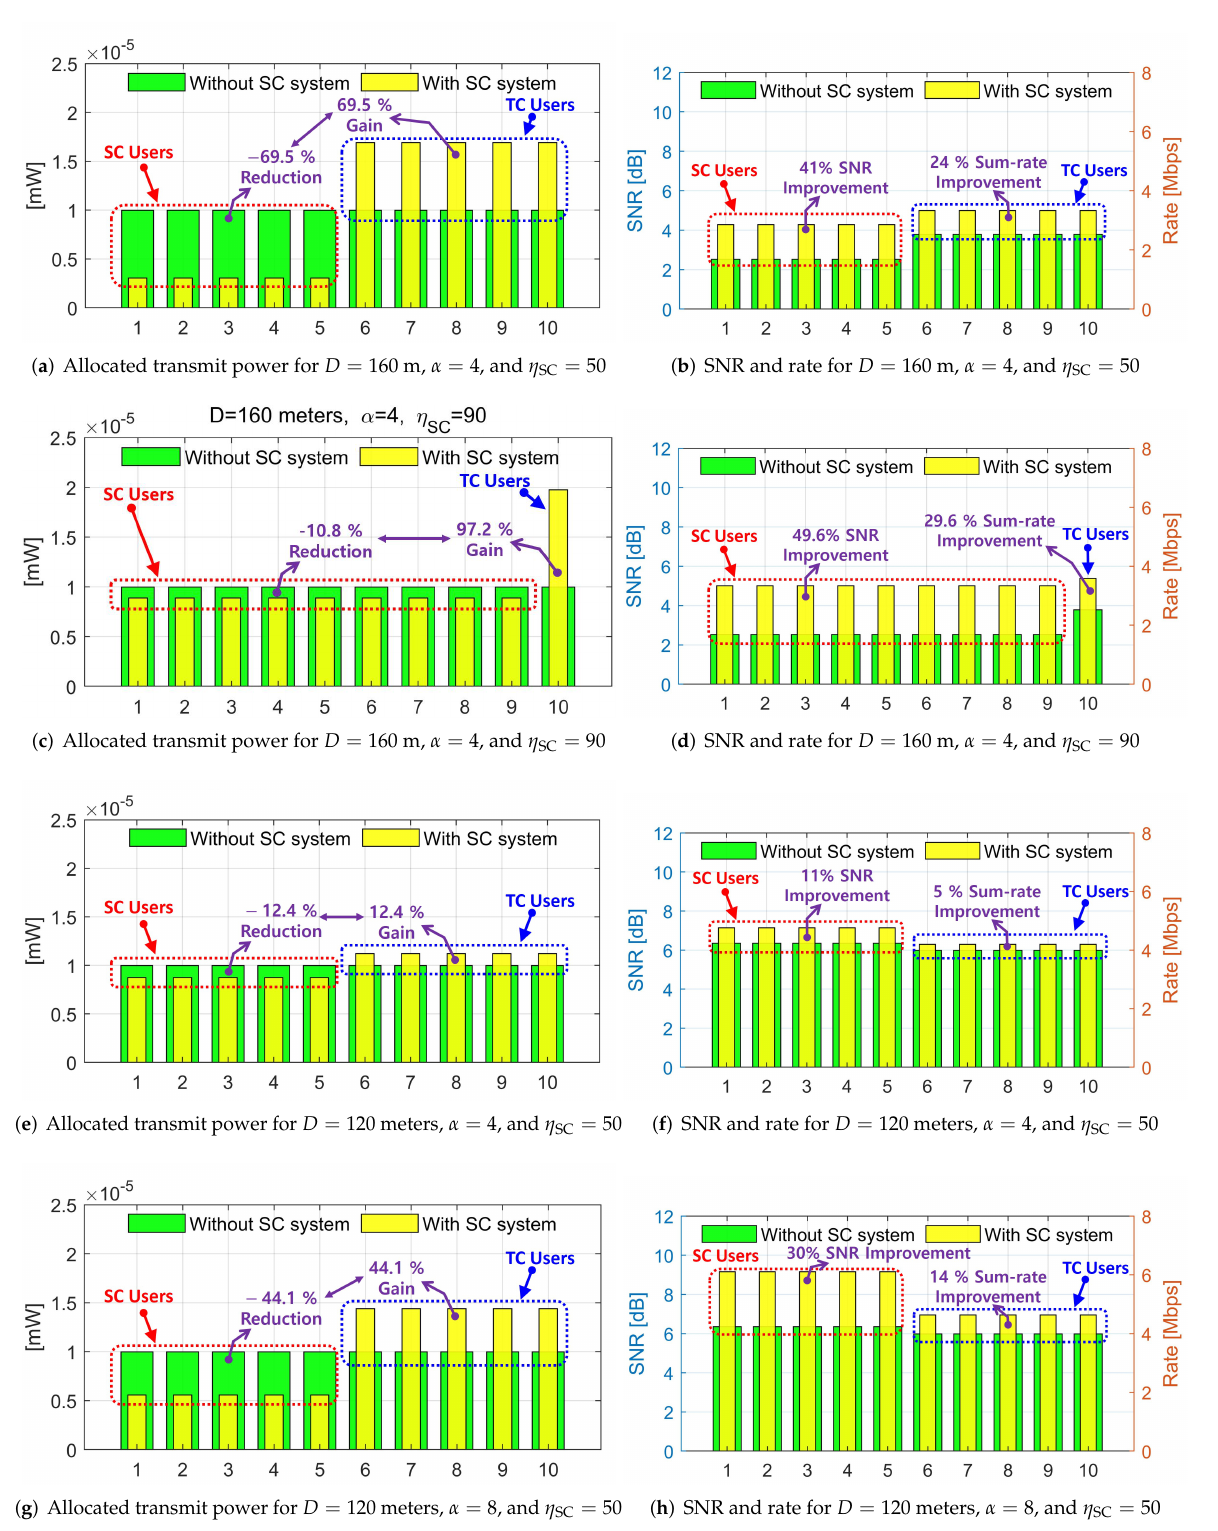
Figure 4. Comparison of the transmit power of all users, the SNR of SC users, and the rate of TC users with and without an SC system for D ∈ { 120,160 } meters, α ∈ { 4,8 } , and η SC = { 50,90 }